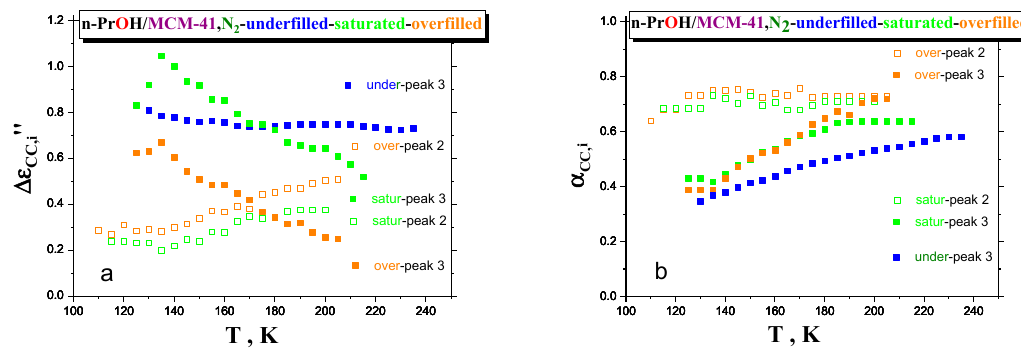
Figure 8. Temperature dependences of the relaxation strength ( a ) and shape parameter ( b ) for all the three variously filled confined n-PrOH/MCM-41, N 2 systems.